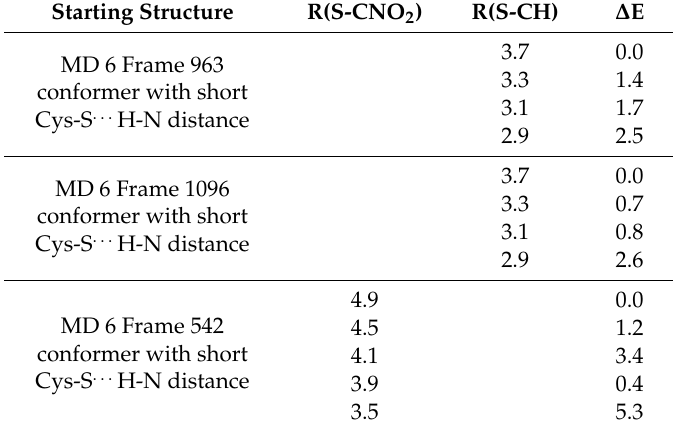
Table 3. Shapes of various addition–reaction pathways of the Cys moiety to the substituted aromatic rings. Relative energies [kcal / mol] are given with respect to the full geometry optimization. The full optimization started from the indicated MD